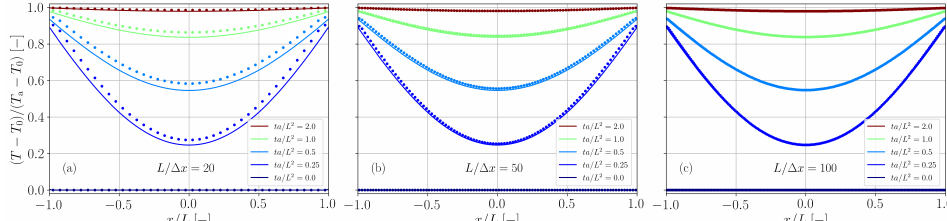
Figure 20. Comparison of simulation results (dots) and analytical solution (solid lines, Equation (63)) for the temperature distribution in a plate with double-sided heat transfer. The spatial resolution is varied between L / ∆ x = 20 ( a ), L / ∆ x = 50 ( b ) and L / ∆ x = 100 ( c